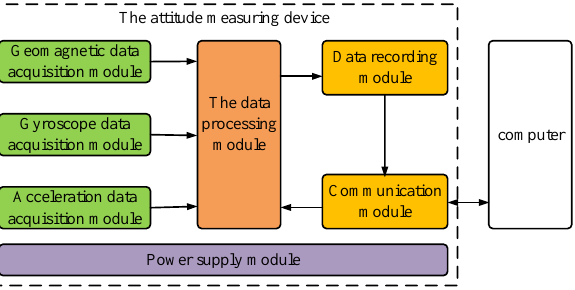
Figure 1. Block diagram of the proposed attitude measuring device.